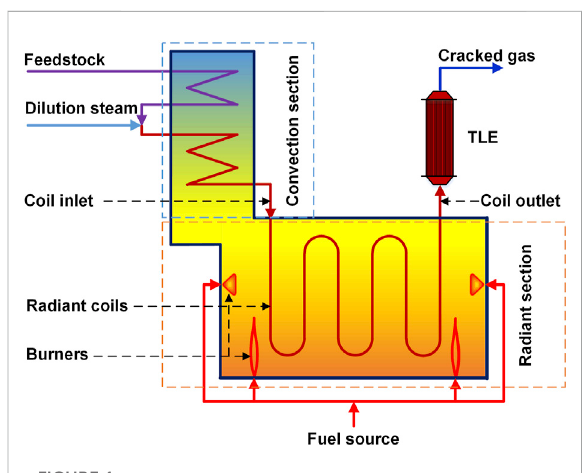
FIGURE 1 Schematic diagram of typical steam cracking furnace. Modi fi ed from Zhang et al.